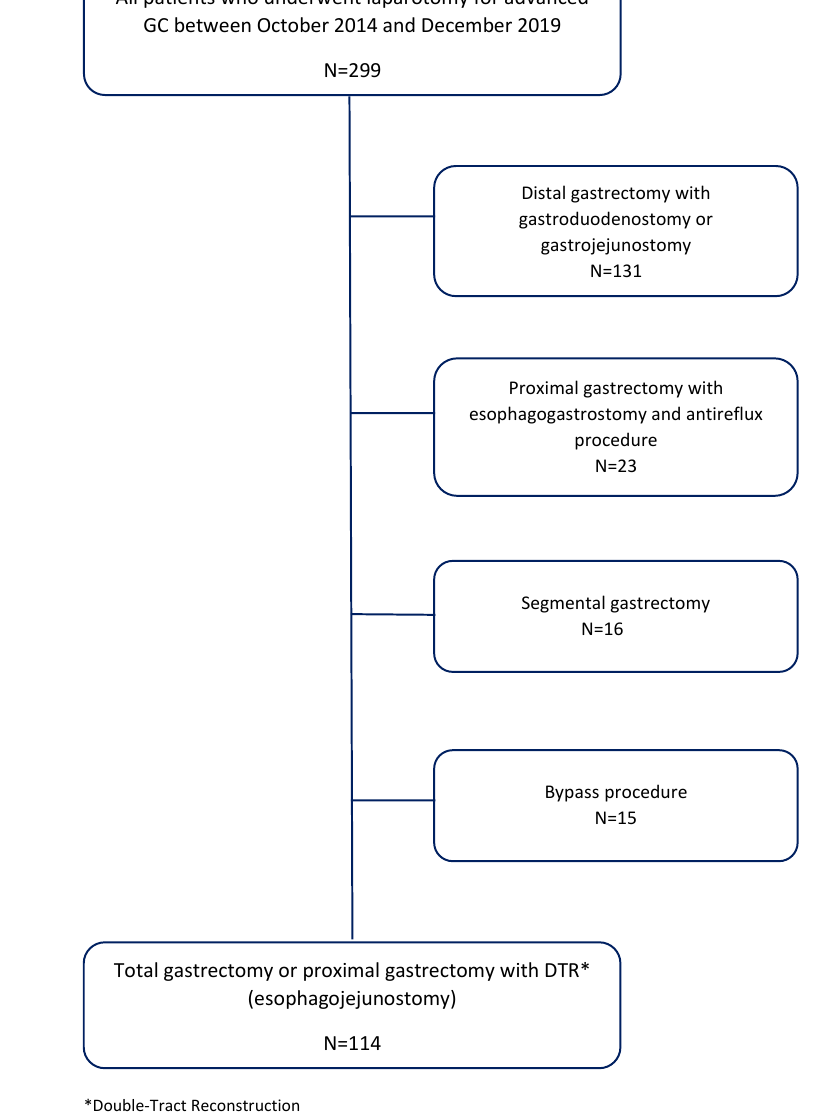
Figure 1. Flow chart of the study.